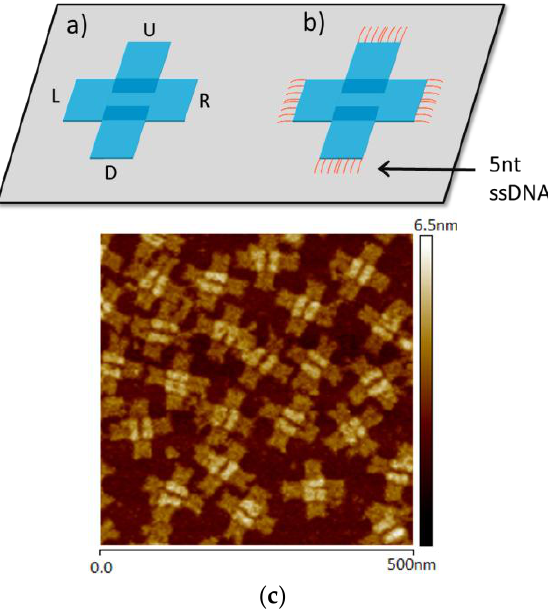
Figure 1. Schematic drawings of the cross-shaped DO with long (cDO) ( a ) and short (cDO E ) ( b ) ssDNA terminations. Representative atomic force microscopy (AFM) image of cDO on mica ( c ).